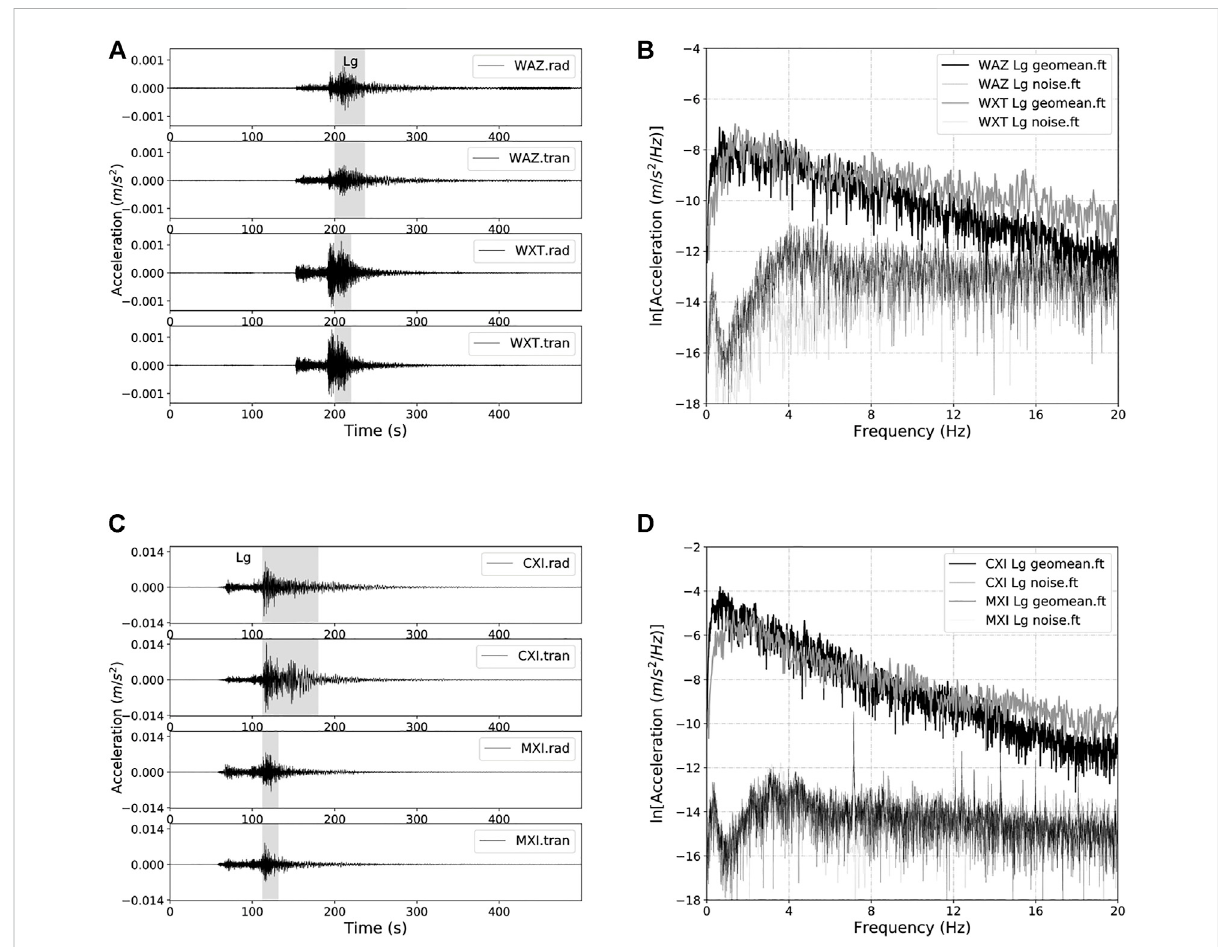
FIGURE 3 (A) Horizontal-component acceleration seismograms from the 18 December 2019 Ms 5.2 Zizhong earthquake recorded at stations WAZ (in northeasternSichuan Basin) and WXT (in northeastern Songpan-Ganze terrane). The epicentral distances for both stations are ~374 km. The shaded areas indicate time windows used for Lg spectral calculations. (B) Corresponding geometric mean of Lg and noise spectra at stations WAZ and WXT. (C) and (D) arethesameas (A) and (B) butfromthe17June2019 Ms6.0ChangningearthquakerecordedatstationCXI(innorthwesternSichuan Basin) and station MXI (in eastern Songpan-Ganze terrane) with epicentral distances of ~385